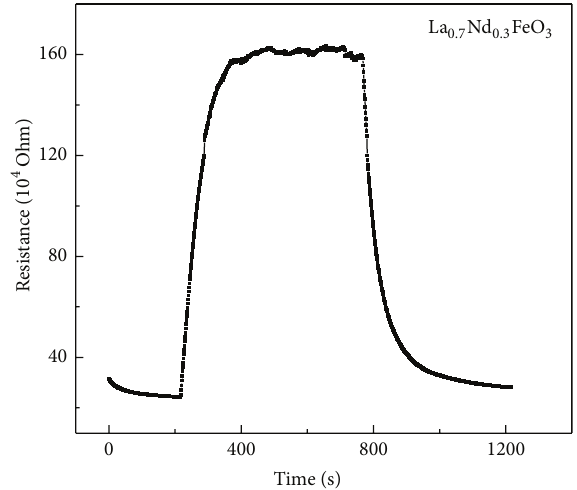
Figure 6: Response and recovery curve of La 0.7 Nd 0.3 FeO 3 when exposed to 0.25 mg/L ethanol at 212 ∘ C.